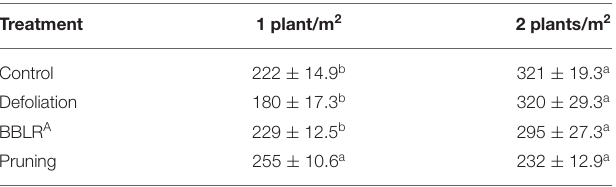
A Removal of branches and leaves from the bottom of the plant. B Different lowercase letters by the averages within a row signifies significant differences between the two density treatments according to Tukey HSD test, at α = 0.05 (n =